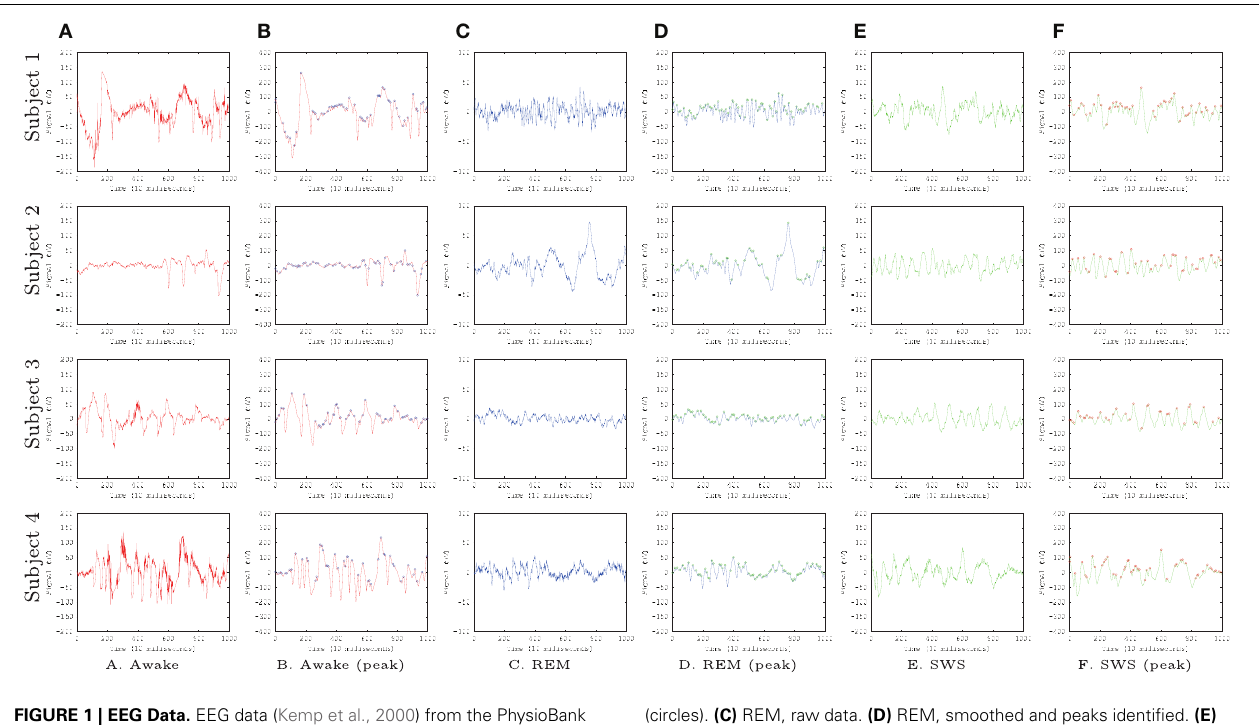
(circles). (C) REM, raw data. (D) REM, smoothed and peaks identified. (E) SWS, raw data. (F) SWS, smoothed and peaks identified. Each data set had 30,000 data points but here we are showing only the first 1000 for a better view of the